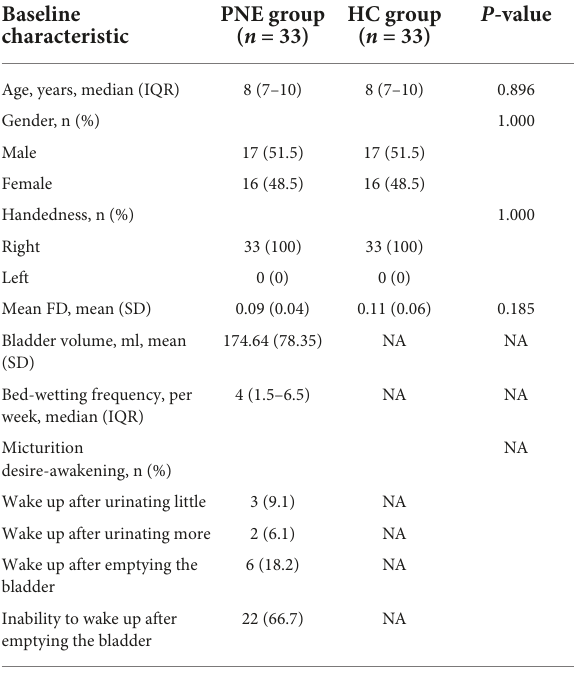
TABLE 1 Demographic and clinical data in PNE and HC